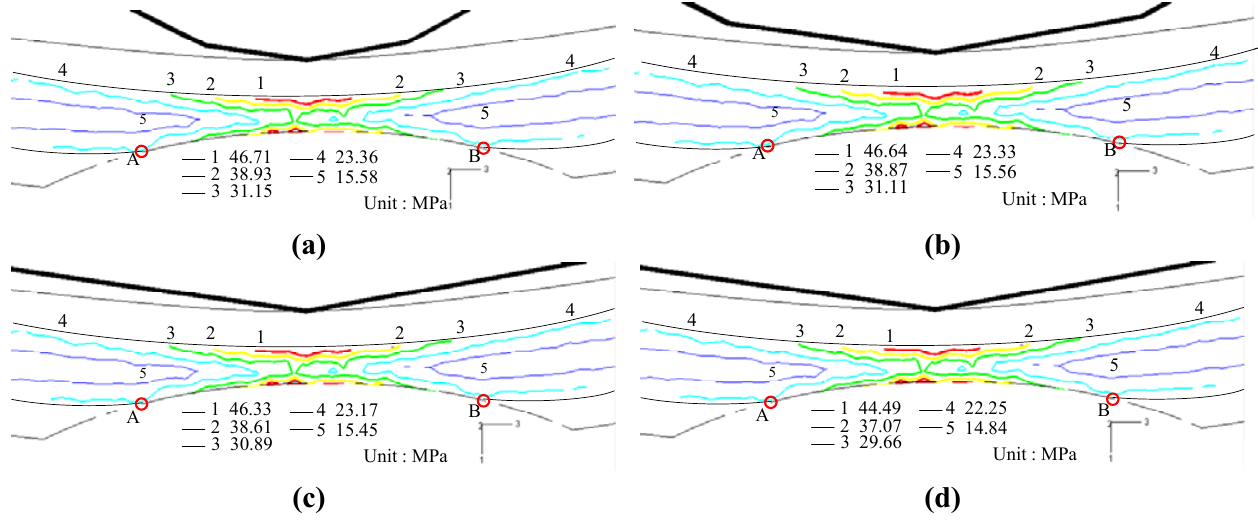
Figure 5. von-Mises stress contours near grooved region at h = 1.1 mm for various disc radii. ( a ) R = 5 mm. ( b ) R = 10 mm. ( c ) R = 15 mm. ( d ) R = 20